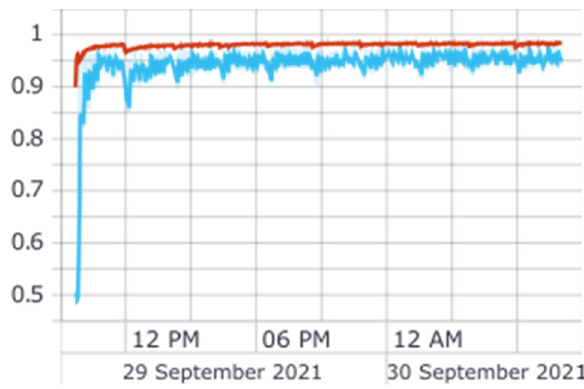
Figure 19. GRU train accuracy (the red line represents accuracy on training data and the blue line accuracy on validation data).